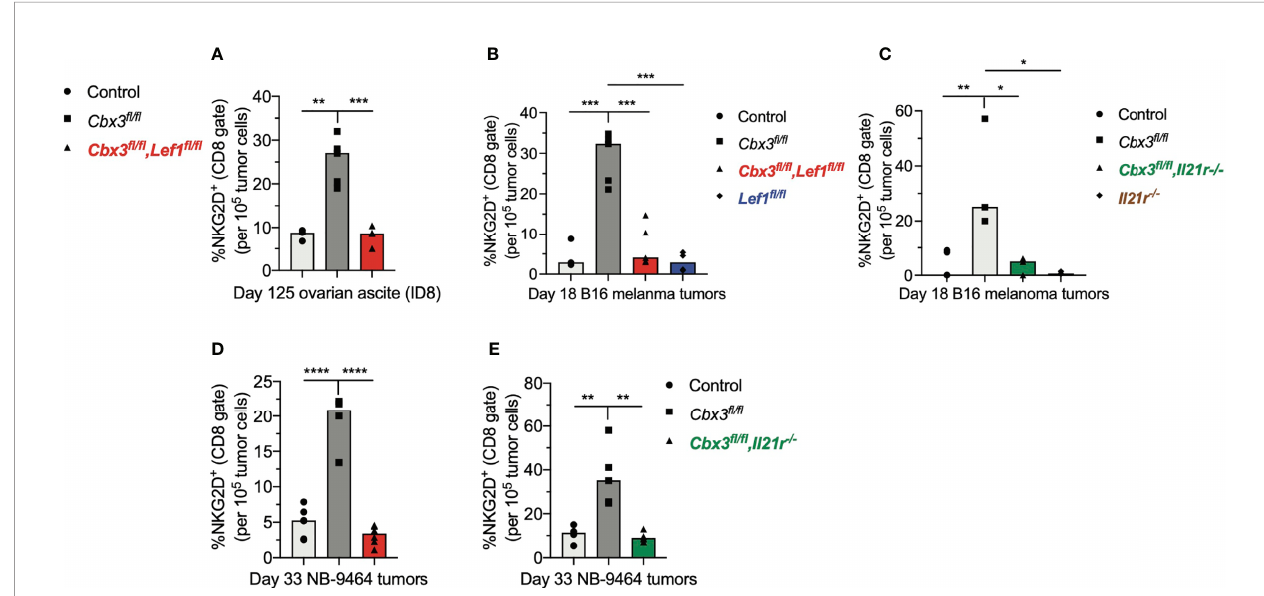
FIGURE 6 | LEF-1 and IL-21R are required for CD8 + effector T cells to persist in tumors. (A) Frequencies of CD8 + NKG2D + T cells in ovarian ascites (from Figure 5 ) were extracted from fl ow analysis; bars: group median; Graphpad unpaired student t-test: **p ≤ 0.01, ***p ≤ 0.001; each symbol = one mouse. (B, C) Frequencies of CD8 + NKG2D + T cells in B16 melanoma tumors (from Figure 5 ) were extracted from fl ow analysis; bars: group median; Graphpad unpaired student t-test: *p ≤ 0.05, **p ≤ 0.01, ***p ≤ 0.001; each symbol = one mouse. (D, E) Frequencies of CD8 + NKG2D + T cells in NBL tumors (from Figure 5 ) were extracted from fl ow analysis; bars: group median; Graphpad unpaired student t-test: **p ≤ 0.01, ****p ≤ 0.0001; each symbol = one